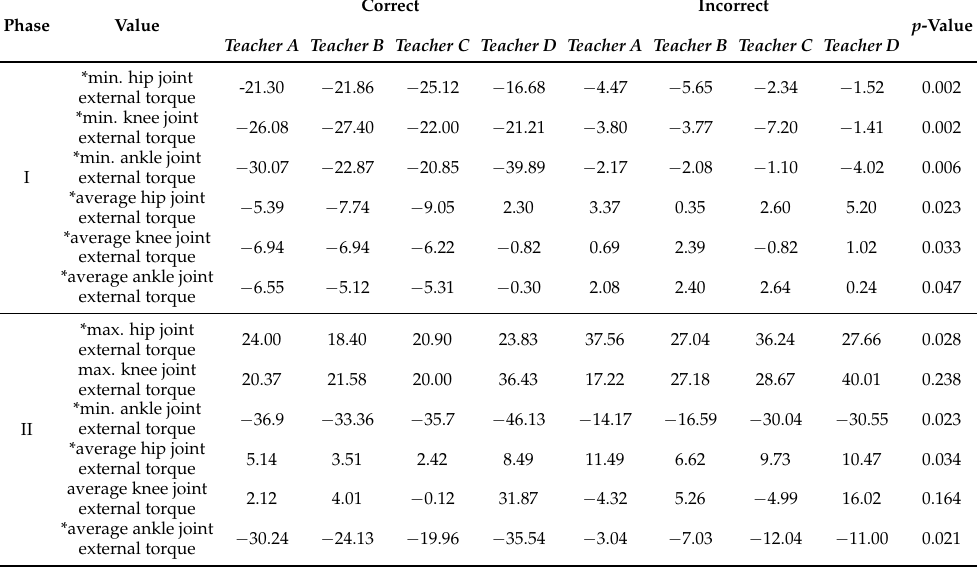
Table 3. External torque measured in the robot